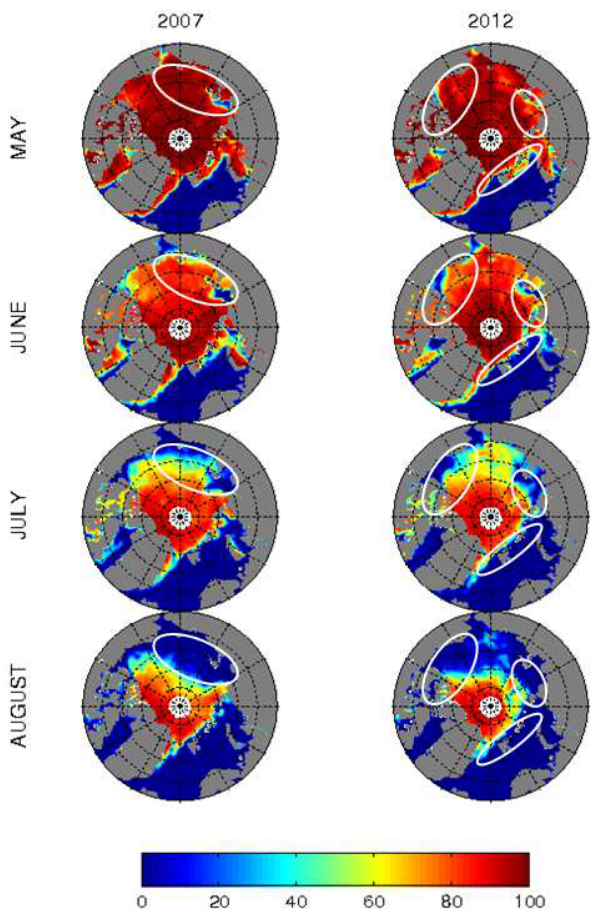
Fig. 12. Monthly mean sea ice concentration from May through Au- Fig. 12: Monthly mean sea-ice concentration from May through August of 2007 (left gust of 2007 (left column) and 2012 (right column). The areas high- column) and 2012 (right column). The areas highlighted by white ellipses show regions lighted by white ellipses show regions that experienced accelerated that experienced accelerated sea-ice melt during these years. The same data set as in Fig. sea ice melt during these years. The same data set as in Fig. 1 is 1 is used. The disappearance of sea-ice is clearly evident in these highlighted areas. used. The disappearance of sea ice is clearly evident in these high- lighted